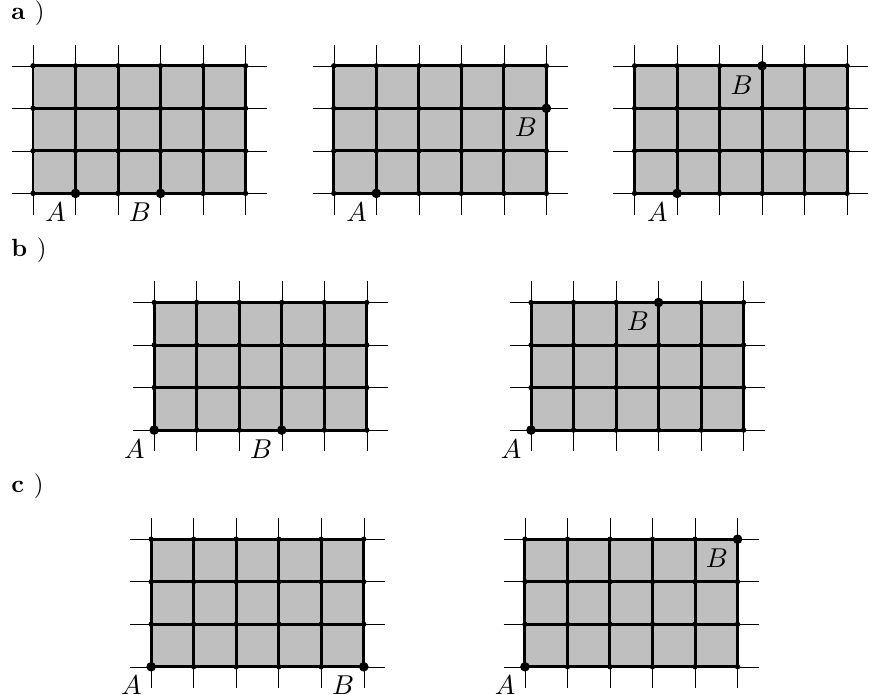
Figure 5. Relative position of points A and B. a) A ∧ B not corner points (left: same edge, middle: adjacent edges, top: opposite edges). b) A ˙ ∨ B is corner point (left: same edge, right: not on same edge). Two generic situations need to be distinguished. c) A ∧ B are corner points (left: same edge, right: not on same edge).